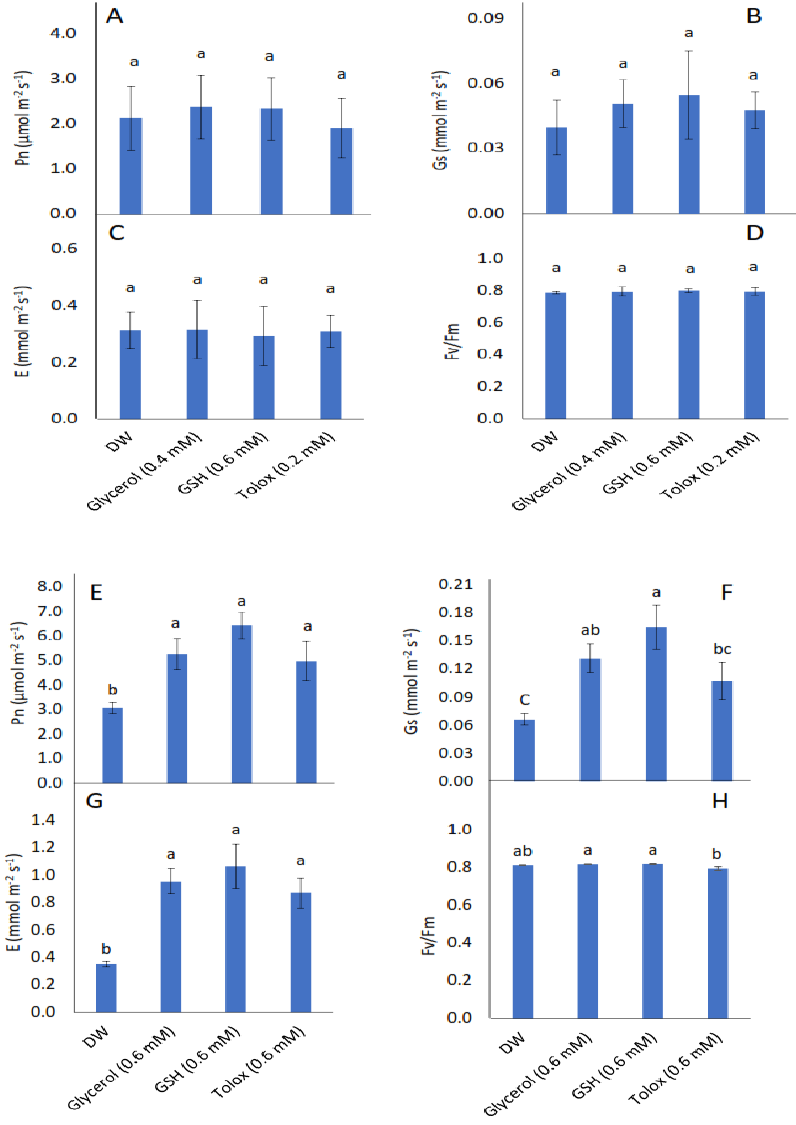
Figure 5. Effect of exogenous application of antioxidants on photosynthetic rate (Pn) ( A , E ), stomatal conductance (Gs) ( B , F ), transpiration rate (E) ( C , G ), and chlorophyll fluorescence (F v /F m ) ( D , H ) in seedlings produced from P25 seeds of cabbage ( B . oleracea ) ( A – D ) and lettuce ( L . sativa ) ( E – H ) sub- jected to soaking in deionised water (DW), glycerol, glutathione (GSH) or trolox. Values represent mean ± SD (3 × n = 5). Bars labelled with different letters indicate significant differences ( p < 0.05,